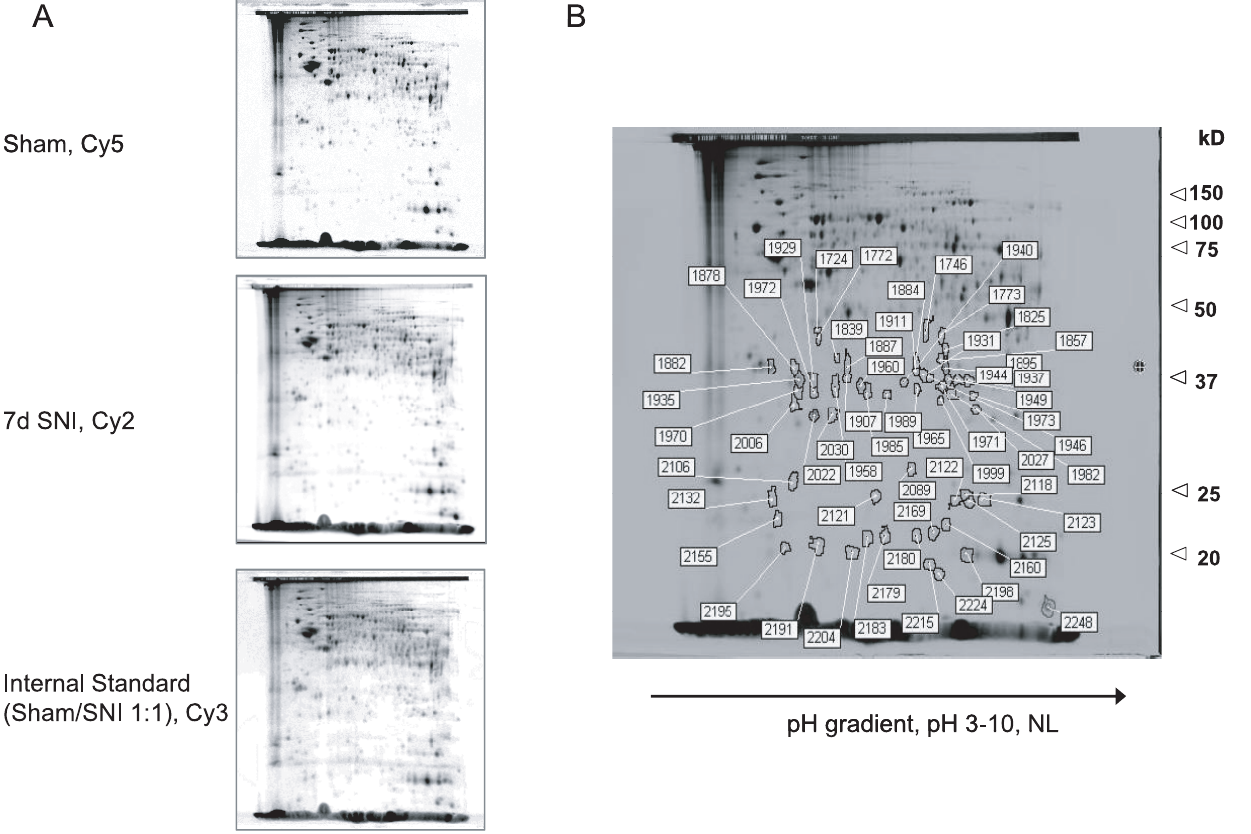
Figure 1. DIGE analysis. (A) Representative 2D-gels of the lumbar spinal cord of sham-operated rats, 7 days after nerve injury and internal control (Sham/SNI 1:1). (B) Overlay of the 3 images indicating regulated protein spots.